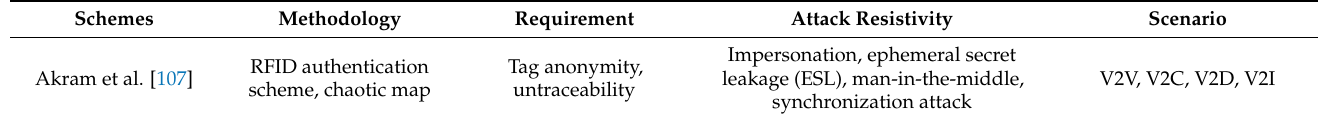
Table 12. Classification of hardware-RFID-tag-based authentication schemes.